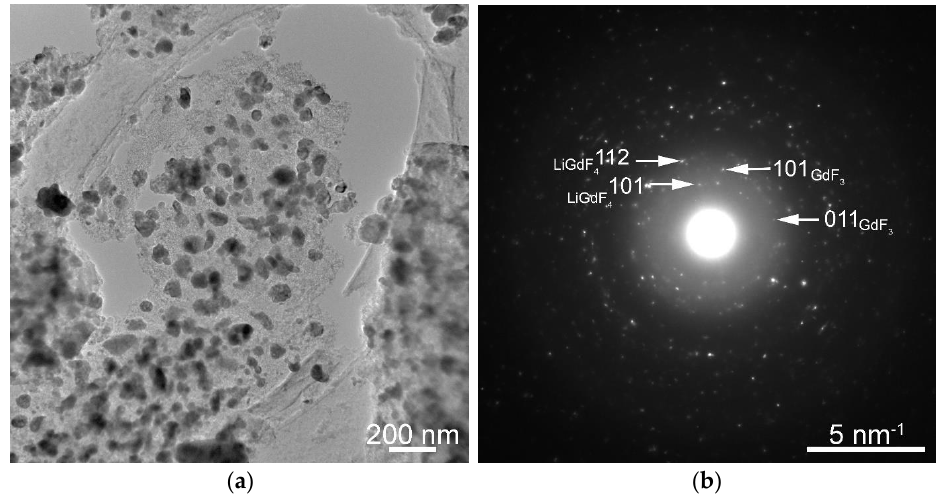
Figure 3. Low-magnification TEM images ( a ) and the corresponding SAED pattern ( b ) of the Yb 3+ /Er 3+ -doped SiO 2 -GdF 3 /LiGdF 4 nano-glass ceramic (2LiGC).